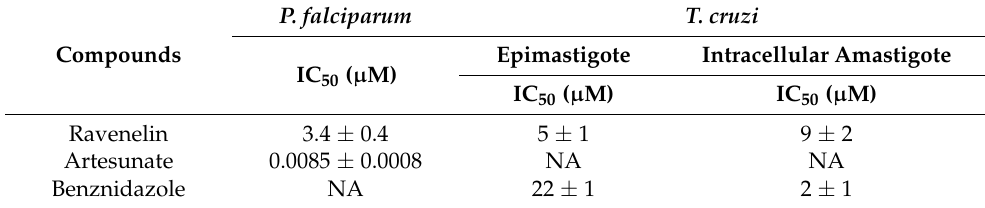
Data represents mean ± SD of at least two experiments. IC 50 : inhibitory concentration for 50% of parasite inhibition. NA, not